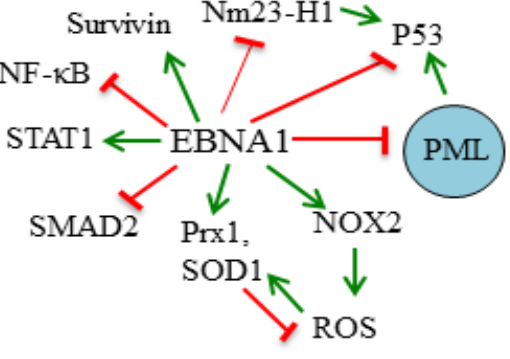
Figure 1. Summary of Epstein–Barr nuclear antigen 1 (EBNA1) effects on cell survival. The cellular proteins whose functions or levels are affected by EBNA1 in ways that likely contribute to increased cell survival are shown. Green arrows represent positive regulation and red blunted lines represent negative regulation. A PML nuclear body is represented by the blue